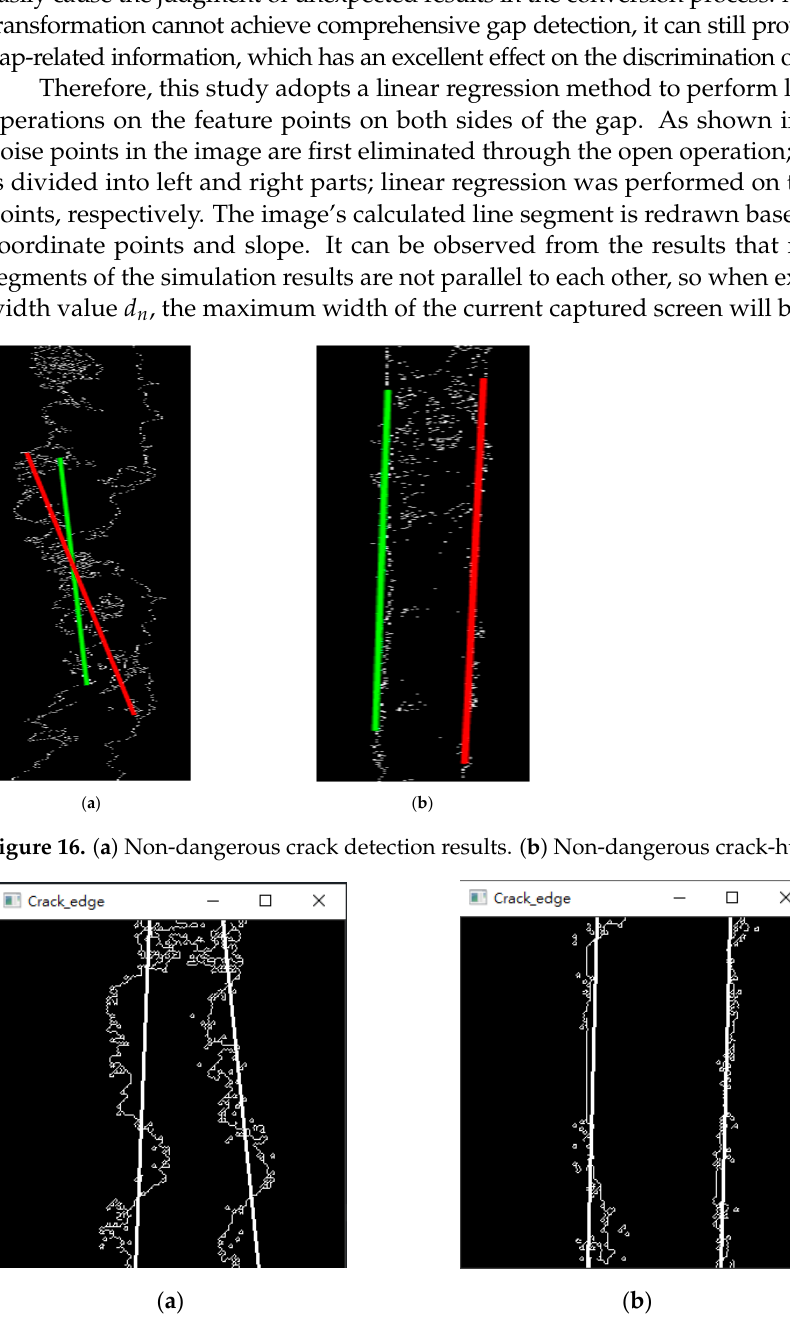
Figure 17. ( a ) Dangerous gap linear regression results. ( b ) Non-dangerous gap linear regression results.